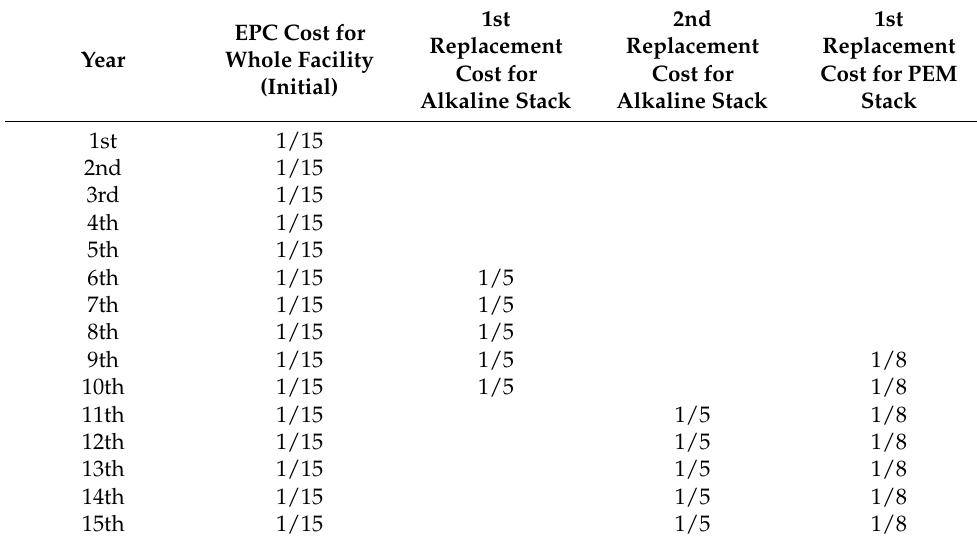
Table 9. Allocation of depreciation